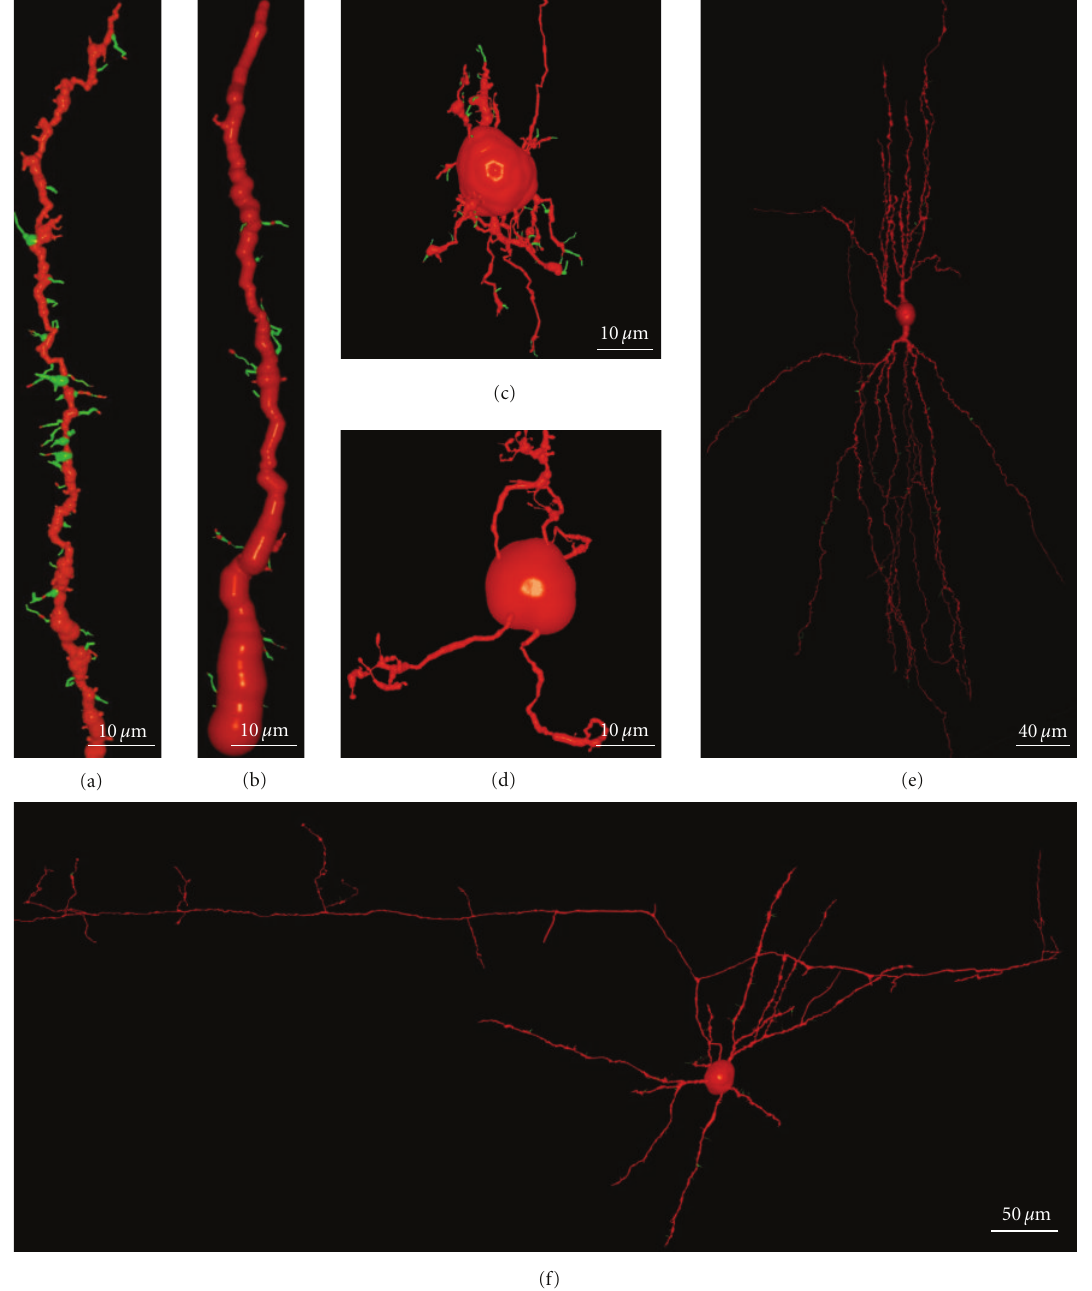
Figure 19: The figure shows filopodia, protospines, and dendritic spines of intrinsic neurons of the cerebellar and cerebral cortices, three- dimensional reconstructions, Cajal histological preparations, Golgi-method. (a) Basket cell dendrite, cerebellum, 17-day-old dog. (b) Golgi cell dendrite, cerebellum, 17-day-old dog. (c) Young immature granule cell, cerebellum, newborn cat. (d) Mature granule cell, cerebellum, adult cat. (e) Double bouquet cell, motor cortex, layer III, one-month-old child. (f) Basket cell, motor cerebral cortex, layer IV, one-month- old dog. Filopodia and protospines are color coded in